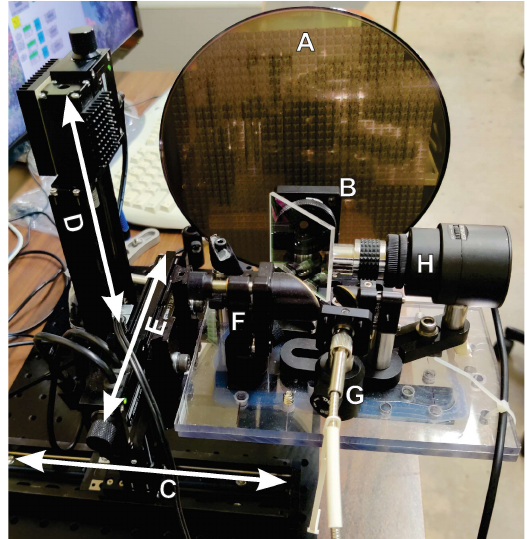
Figure 2. Nanoscanner setup for non-contact scanning T-ray beams and a stationary wafer mounting system. Any sample may be mounted and scanned over a user-defined volume. A: A 200 mm patterned wafer. B: Aperture for T-ray beam control. C, D, E: Nanoscanner axes: C: X-axis, 200 mm. D: Y-axis, 200 mm. E: Z-axis, 50 mm. F: T-ray control circuit. G: Fiber-coupled T-ray delivery. H: Objective with the detection system.